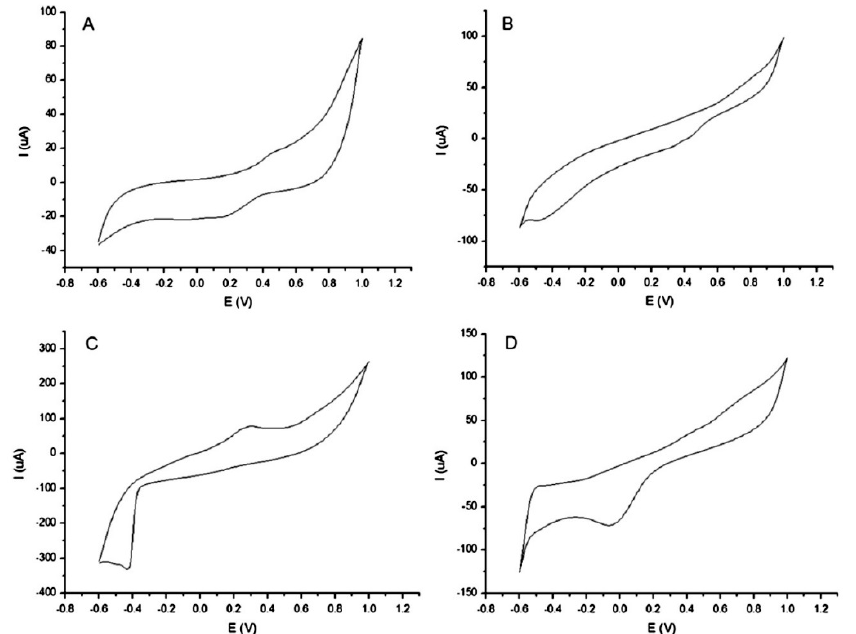
Figure 4. Cyclic voltammograms registered with an array of four commercial screen-printed sensors exposed to a beer sample. ( A ) DS-110; ( B ) DS-250AT; ( C ) DS-410; and ( D ) DS-550. Reproduced from [48] with permission.